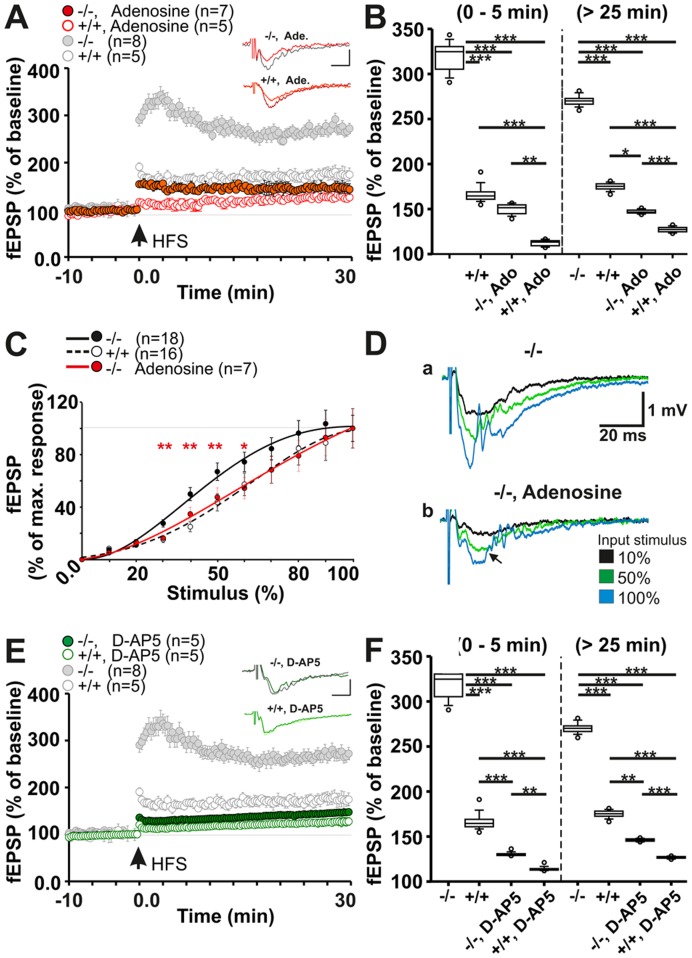
Pre- and postsynaptic components of altered Panx1−/− LTP.a, Evoked LTP in presence of 3 µM adenosine: Panx1−/− derived fEPSPs during early and persistent LTP phases are restored towards LTP levels of the untreated controls. Figure insets in (a) indicate −/− and +/+ original responses under blocking conditions before and 30 min post HFS (scale horizontal: 10 ms, vertical: 0.5 mV). b, Comparison for early phase (0–5 min) and persistent phase LTP (25–30 min). All conditions differ significantly from the Panx1−/− (see Figure 1). c, IO- correlation of the adenosine-treated Panx1−/− in comparison to Panx1−/− and Panx1+/+ under ACSF conditions. Adenosine treatment normalized the input sensitivity of the Panx1−/− towards values of the untreated controls (Panx1+/+). d, fEPSP sample traces of the Panx1−/−, revealing a decrease in oscillatory activity (arrow) and amplitudes. e, NMDA dependence of −/− and +/+ derived LTP after application of 50 µM D-AP5. NMDA inhibition leads to decrease of the signal during early and persistent phase of LTP, as demonstrated in (f). f, All conditions differ significantly from the Panx1−/−. Statistics: (b) ANOVA (early: F3,64 = 157.9; P<0.0001; late: F3,64 = 458.7; P<0.0001), (f) ANOVA (early: F3,64 = 184.9; P<0.0001; late: F3,64 = 547.4; P<0.0001).